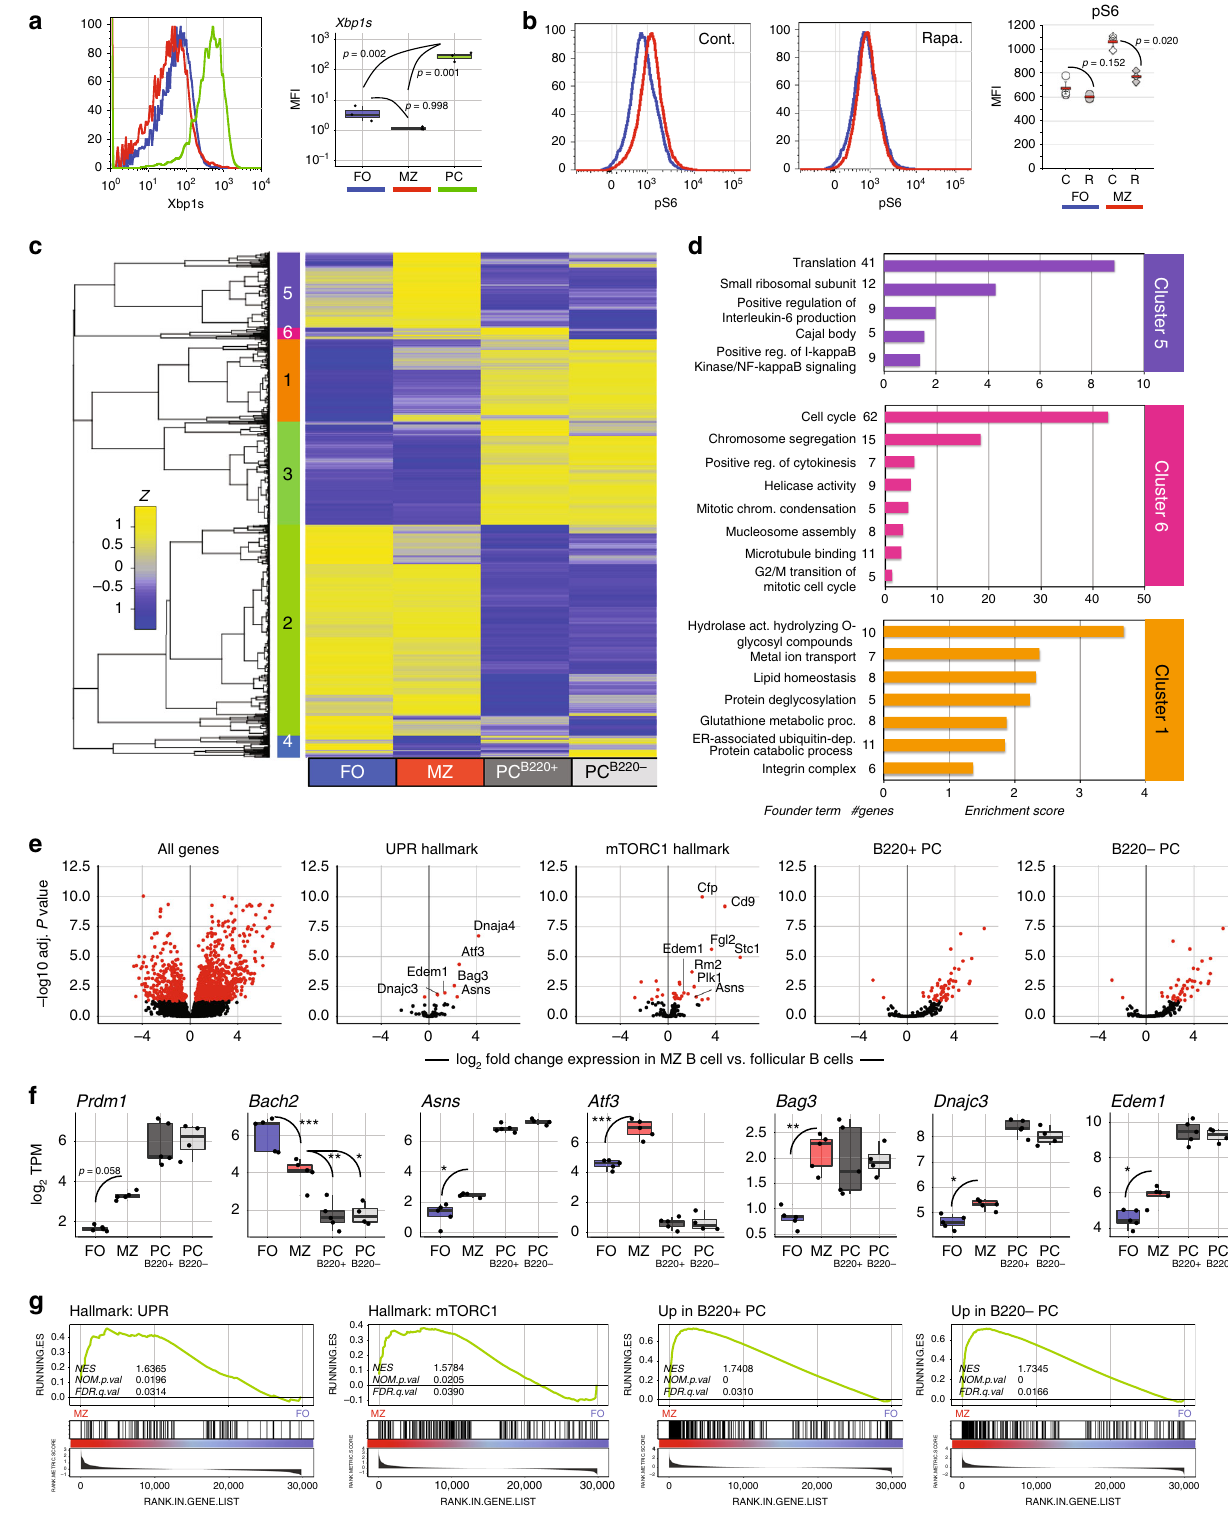
( Prdm1 ), and modest decreases in transcript abundance for Bach2 ( Bach2 ), a negative regulator of Blimp1 transcription 35 (Fig. 2f). Importantly, other components of the canonical plasma cell GRN were not signi fi cantly changed; for instance, we observed no differences in mRNA levels between follicular B cells and MZ B cells for Pax5 or Bcl6 (Supplementary Fig. 2d).